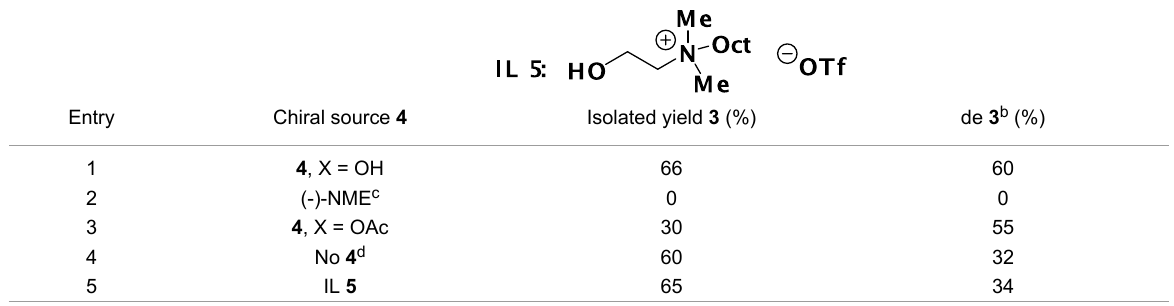
Table 4: Asymmetric aza-Diels-Alder reaction of diene 1 with imines 2 (R = Ph). Conditions a : imine 2 :diene 1 :IL 4 (R' = C 8 H 17 , Y = OTf) = 1:1.5:2; temperature: 30°C; time: 4.30 h